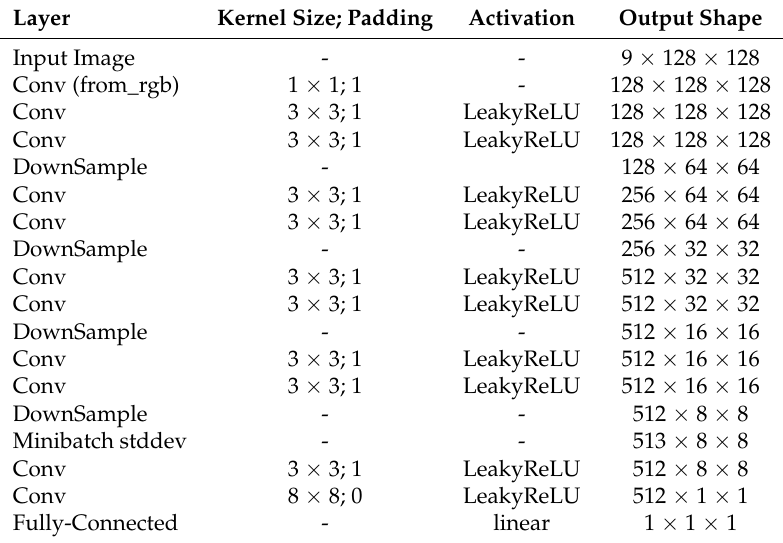
Table A2. The cStyleGAN